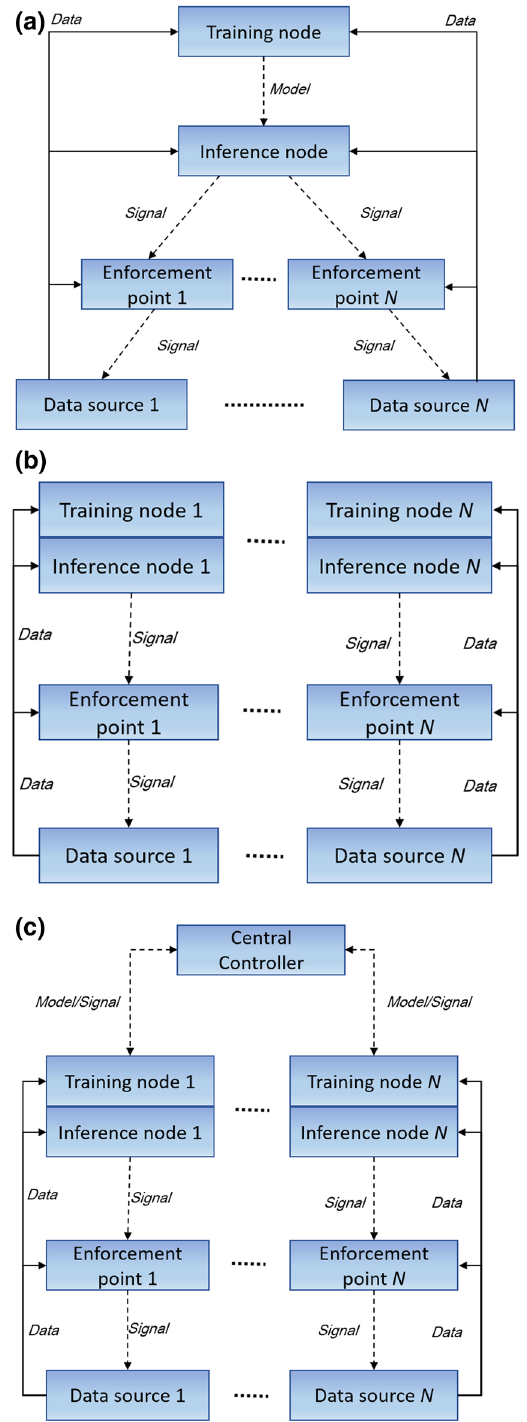
Fig. 7 Logical architecture of learning systems under three AI architectures. a Centralized, b Decentralized and c